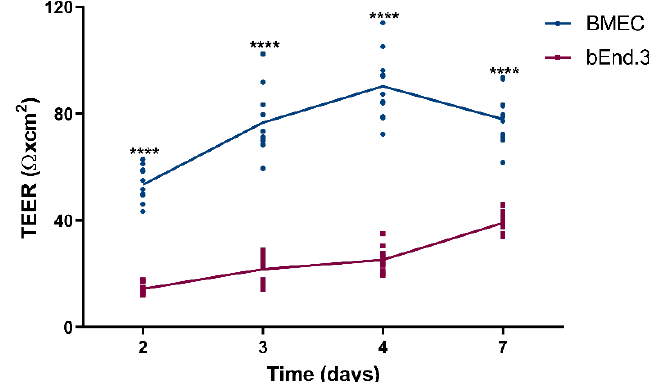
Figure 1. ( a ) Transendothelial electrical resistance (TEER, expressed as Ω × cm 2 ) and ( b ) endothelial Pe for sodium fluorescein (NaFl) and FITC-dextran (Pe, expressed in cm / s) of the blood–brain barrier Figure 3. ( a ) Transendothelial electrical resistance (TEER, expressed as Ω × cm 2 ) and ( b ) endothelial models built from mouse primary brain endothelial cells (BMEC, blue) and from mouse brain endothelial Pe for sodium fluorescein (NaFl) and FITC-dextran (Pe, expressed in cm/s) of the blood–brain barrier cell line (bEnd.3, red) at day 7. All data are presented as means ± SD ( n = 12 for TEER, n = 4 for models built from mouse primary brain endothelial cells (BMEC, blue) and from mouse brain Pe). Statistical analysis: unpaired t test with Welch’s correction (ns: p ≥ 0.0332, **** p < 0.0001, ND- endothelial cell line (bEnd.3, red) at day 7. All data are presented as means ± SD ( n = 12 for TEER, n = not 4 for Pe). Statistical analysis: unpaired t test with Welch’s correction (ns: p ≥ 0.0332, **** p < 0.0001, ND- not detected).